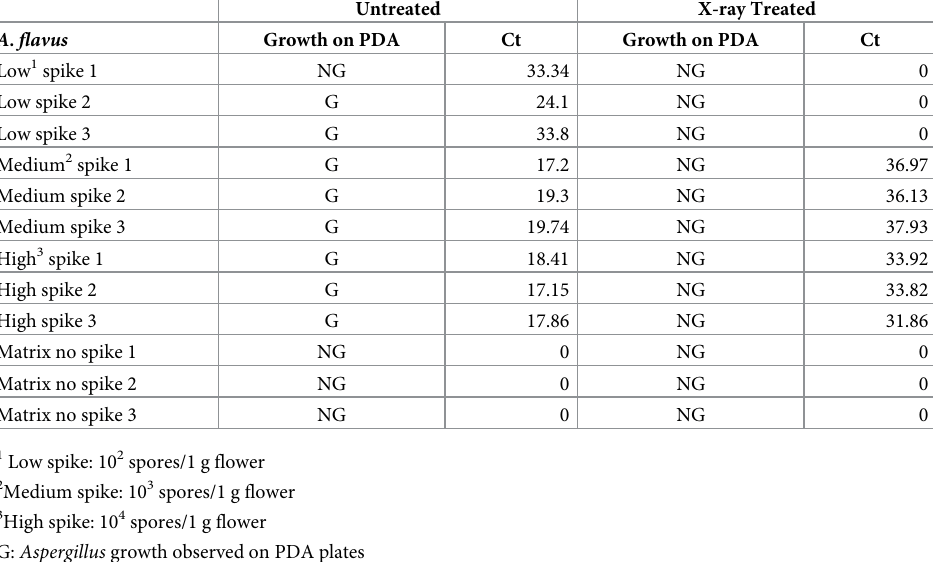
cycle thresholds than comparable untreated samples. A sample was considered “positive”, DNA detected, for an Aspergillus target if fluorescent curves crossed the cycle threshold (Ct) line � 40. A Ct of zero means that the fluorescent curve did not cross the cycle threshold.